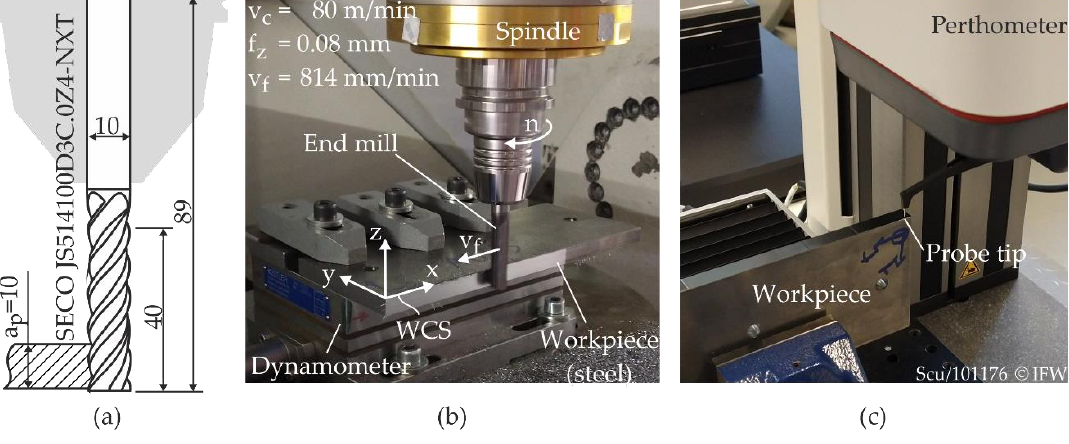
Figure 8. ( a ) End mill. ( b ) Milling setup. ( c ) Perthometer setup.